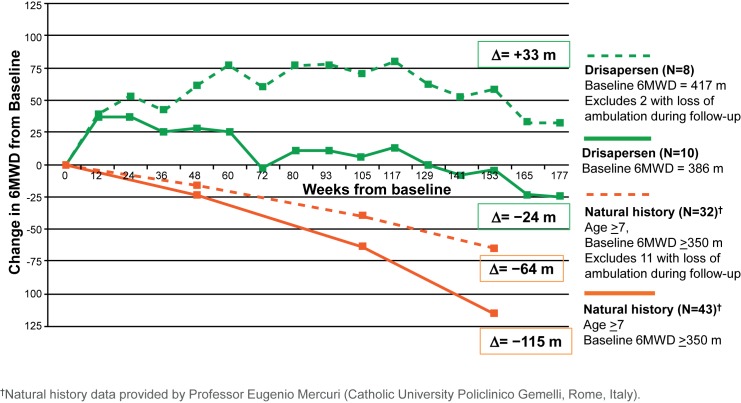
Comparison of change from baseline in 6MWD from drisapersen-treated subjects with natural history data.The continuous line includes all patients from the drisapersen cohort or natural history cohort for which the 6MWD was available, whereas the dashed line shows the same cohorts but excludes patients that lost ambulation during follow-up. †Natural history data provided by Professor Eugenio Mercuri (Catholic University Policlinico Gemelli, Rome, Italy) 6MWD: six-minute walk distance.